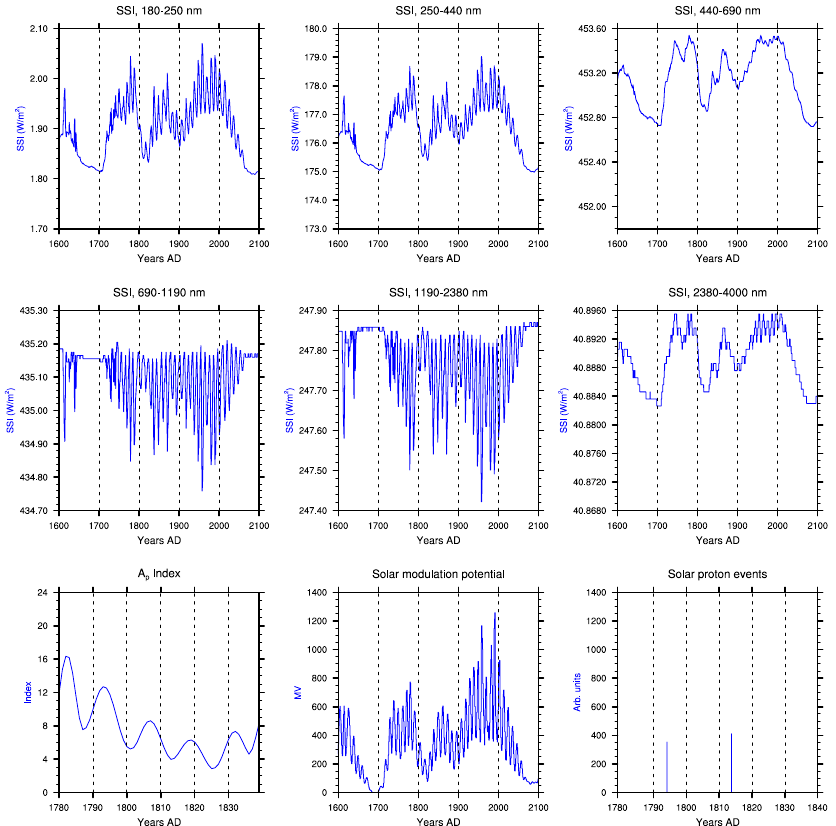
Fig. 1. Spectral solar irradiance (SSI) adapted from Shapiro et al. (2011) and A p -index, solar modulation potential and SPE during the DM. From left to right, top to bottom: hard UV (185–250nm, band 1), soft UV (250–440nm, band 2), visible (440–690nm, band 3), IR- A (690–1190nm, band 4), IR-B (1190–2380nm, band 5), IR-C (2380–4000nm, band 6), A p -index, Solar modulation potential ( 8 ), and